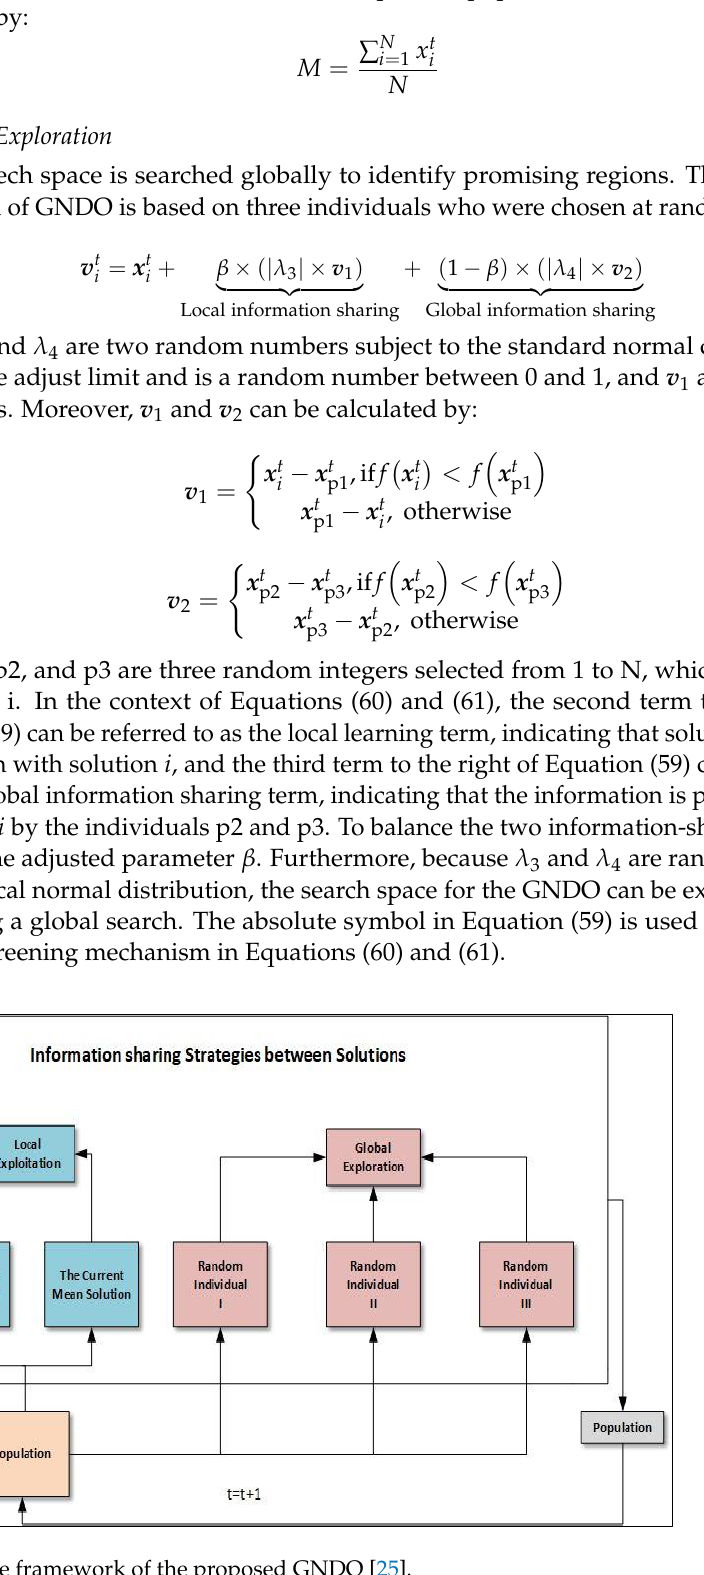
Figure 7. The framework of the proposed GNDO